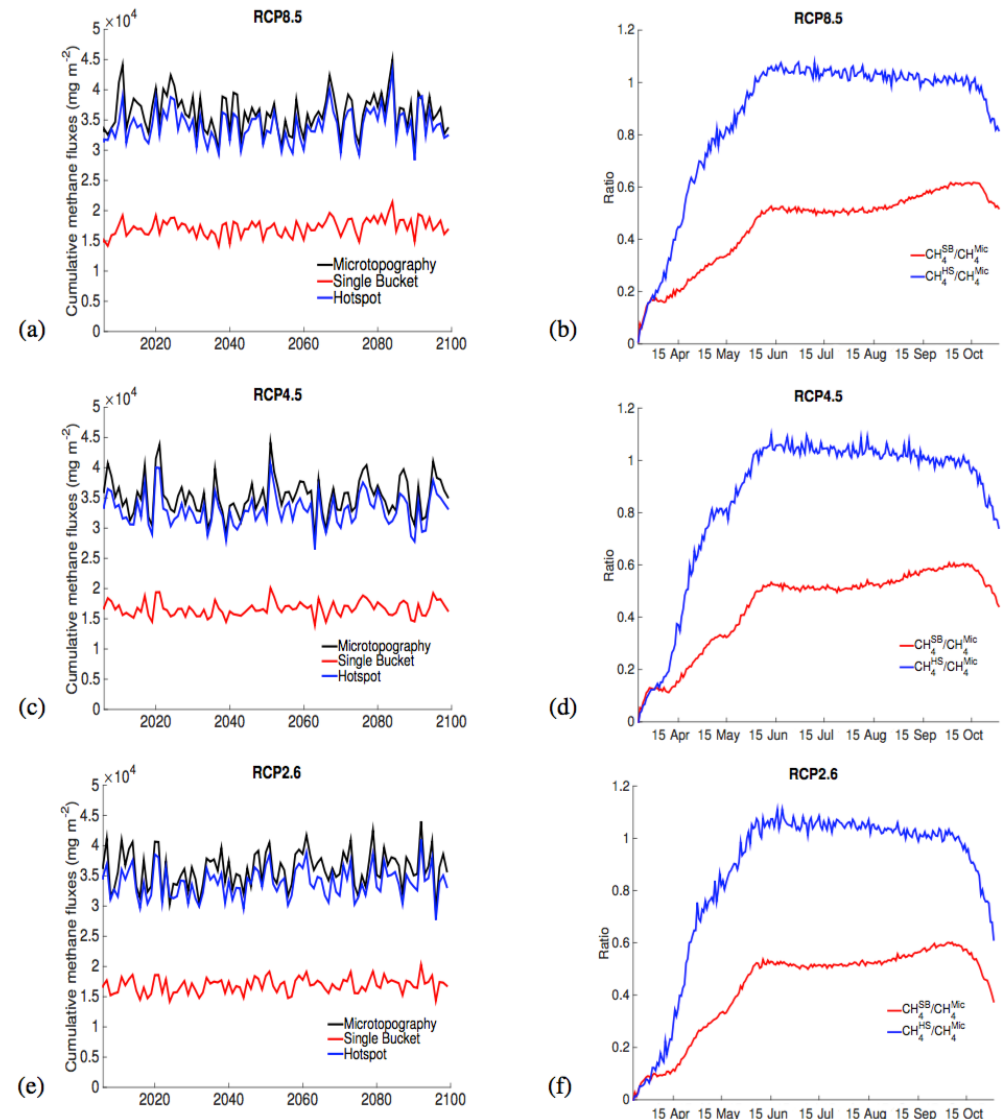
Figure 4. Performances of the three configurations of the HH model for future projections in different scenarios. Panels (a) , (c) , and (e) represent seasonally cumulated methane emissions computed by the HH model forced with CMIP5 data for the time period 2006–2099 from the RCP8.5, 4.5, and 2.6 experiments respectively. Panels (b) , (d) , and (f) represent the seasonal effectiveness of the Hotspot parameterization for future projections, forced with CMIP5 data for the time period 2006–2099 from the RCP8.5, 4.5, and 2.6 experiments respectively. We illustrate the ratio of methane emissions with respect to the Microtopography configuration for the Hotspot parameterization (in blue) and the Single Bucket configuration (in red). We averaged each day of simulation over the 2006–2099